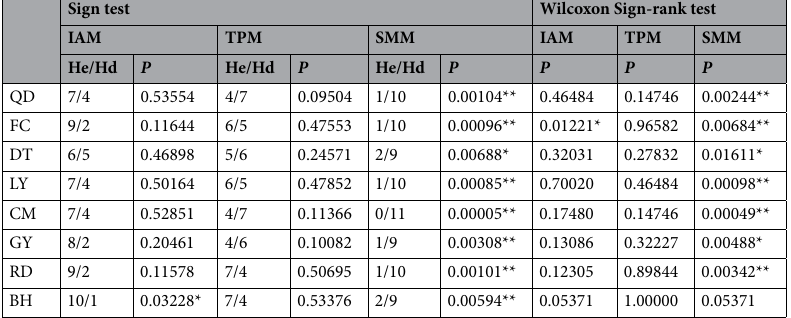
Table 6. Results of mutation-drift equilibrium tests of eight L. maculatus populations. LY Lieyu, CM Chongming, DT Dongtou, QD Qingdao, FC Fangcheng, GY Ganyu, RD Rudong, BH Binhai, He/Hd represents the ratio of heterozygote excess and heterozygous deficiency loci number. *Means significant deviation from equilibrium ( P < 0.05). **Means extremely significant deviation from equilibrium ( P <